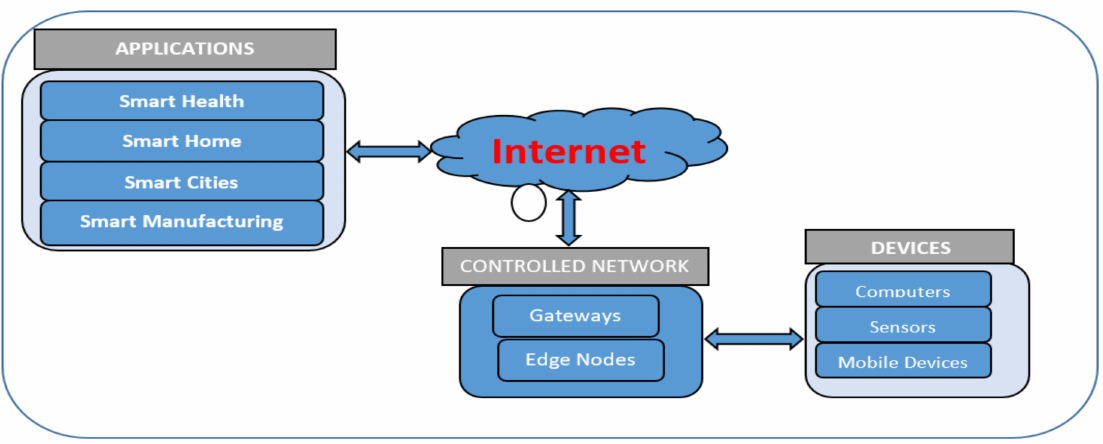
Figure 1. Internet of Things